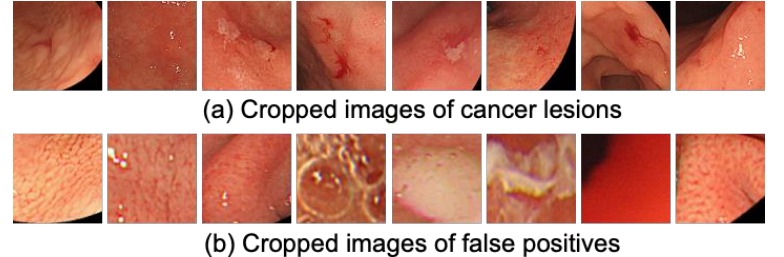
Figure 5. Example of the cropped images for false positive reduction: ( a ) Cropped images of cancer lesions; ( b ) Cropped images of false positives.